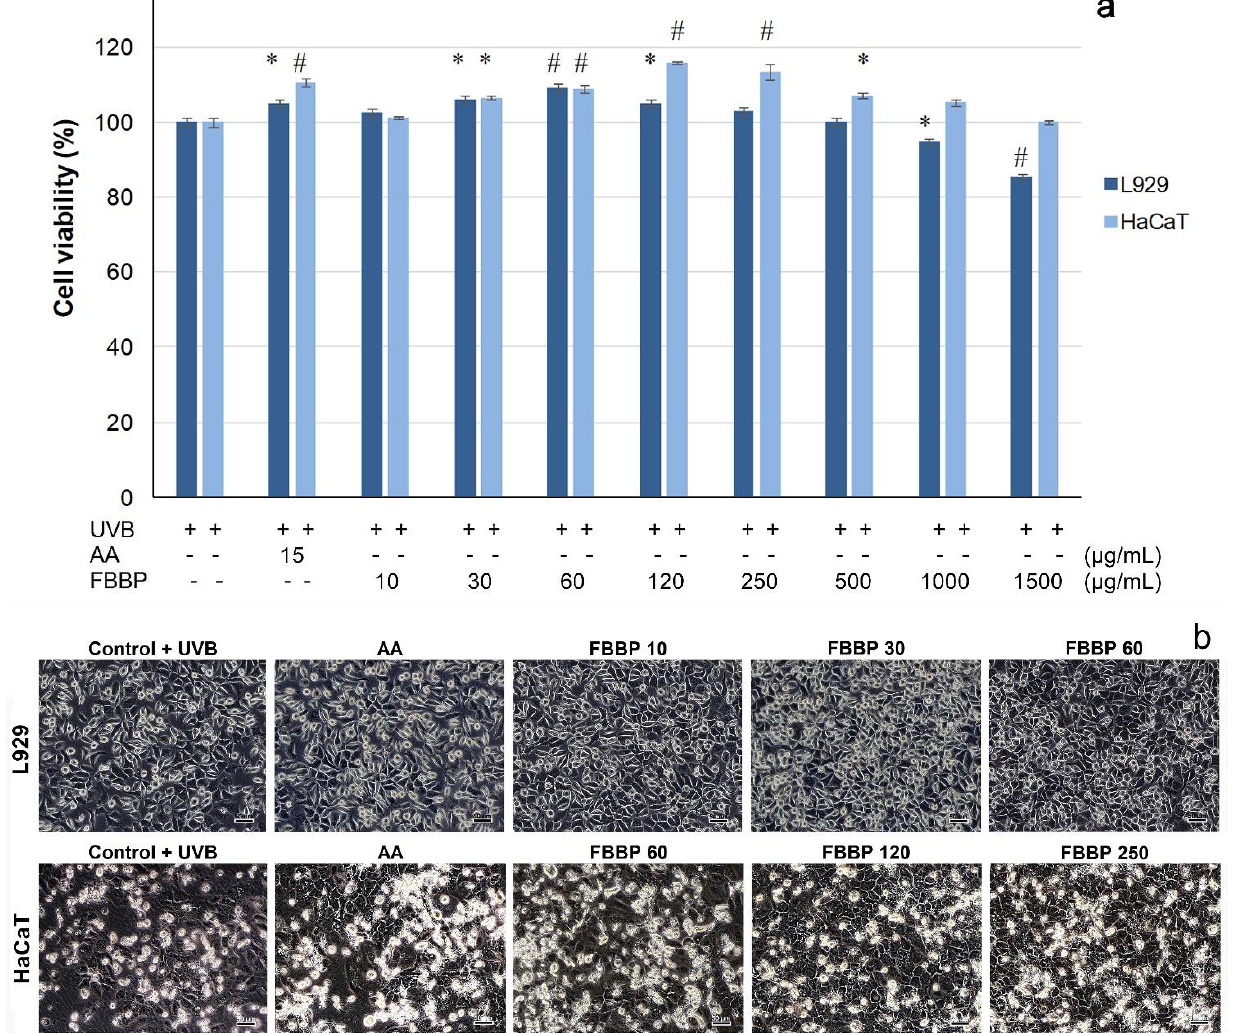
Figure 4. Cell viability of L929 and HaCaT pretreated with different concentrations of FBBP and AA, exposed to UVB irradiation and cultivated for 24 h, as determined by MTT assay ( a ). The values are expressed as mean ± SD ( n = 3). * p < 0.05 and # p < 0.01, compared to UV control. H 2 O 2 -treated cells served as positive control. Light microscopy observations of cell morphology in UVB-irradiated L929 and HaCaT cells pretreated with different concentrations of FBBP ( b ). Bar scale = 50 µm.